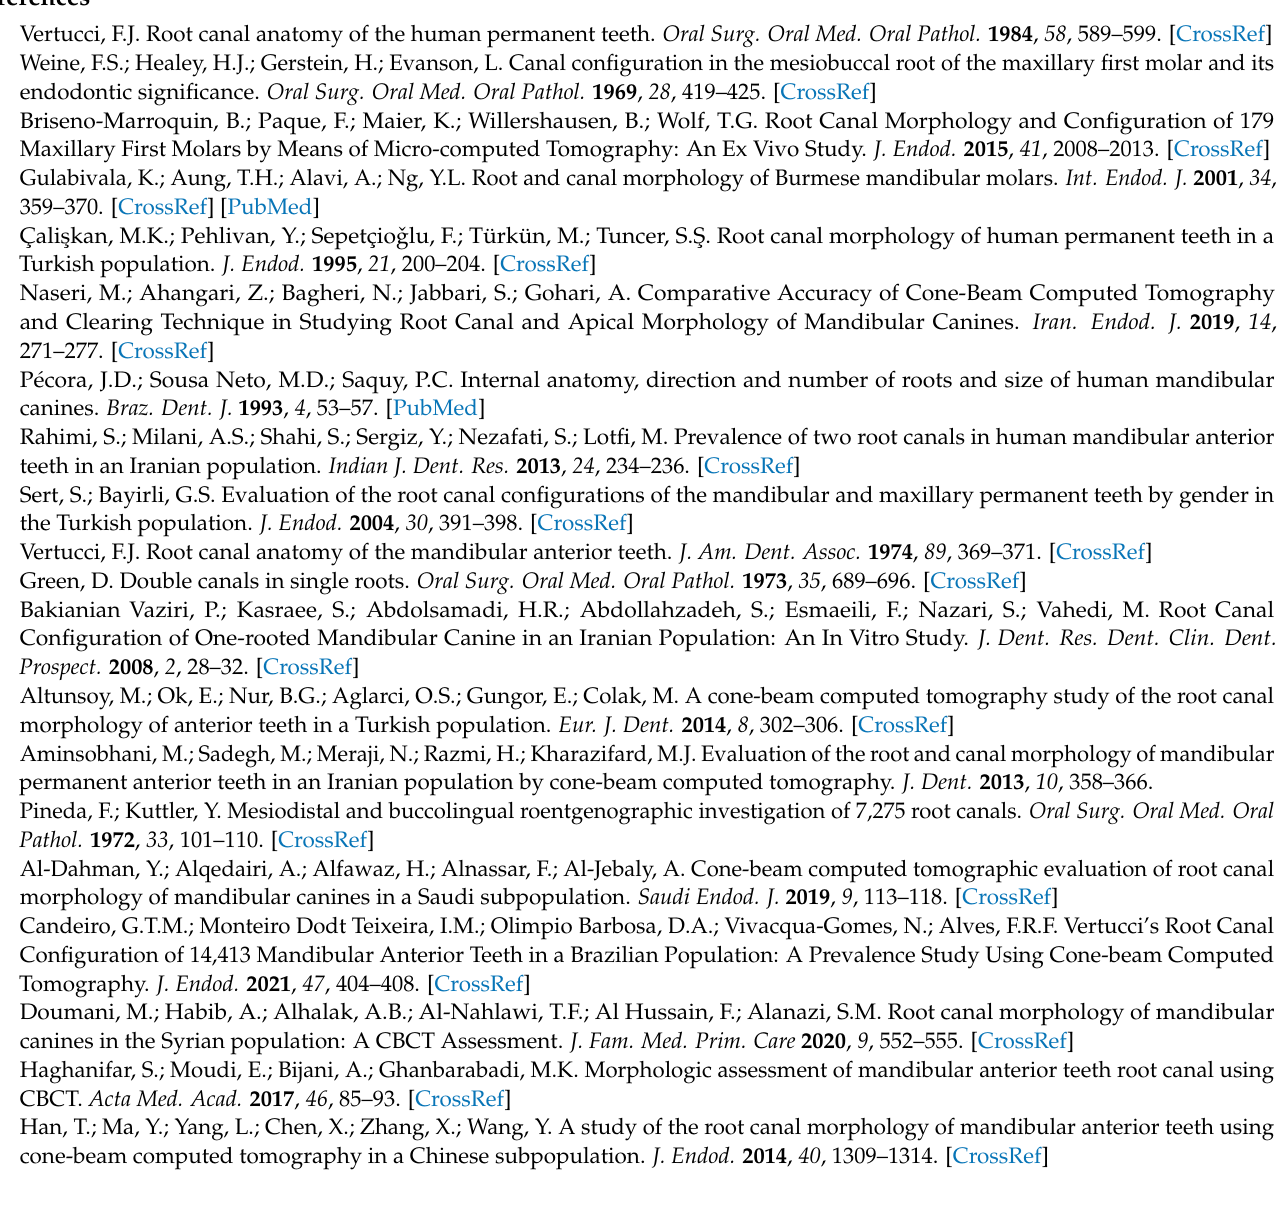
Materials (Table S1: List of excluded papers, Table S2: Quality Assessment, Table S3: AQUA Tool Evaluation, Table S4: List of included papers after full text evaluation, S5: PRISMA